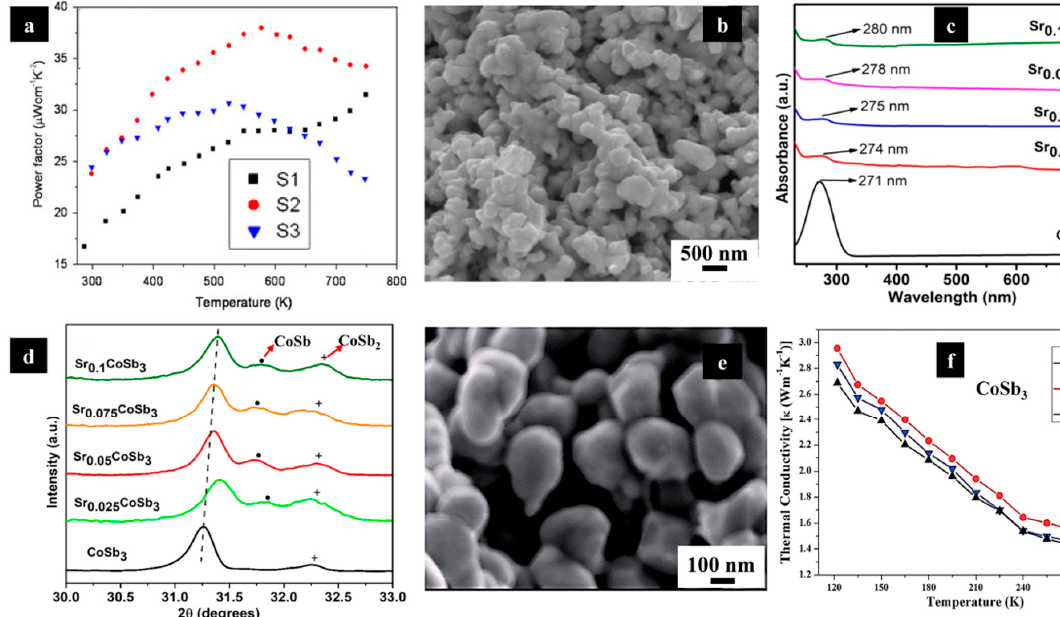
Figure 3. ( a ) Temperature dependence of power factor for In-filled and Te-doped CoSb 3 samples. S1: Co 4 Sb 11.5 Te 0.5 sample (500 ◦ C × 24 h), S2: In 0.5 Co 4 Sb 11.5 Te 0.5 sample (long-time annealing); and S3: In 0.5 Co 4 Sb 11.5 Te 0.5 sample (short-time annealing) [31]; ( b ) FESEM image of Sr 0.05 CoSb 3